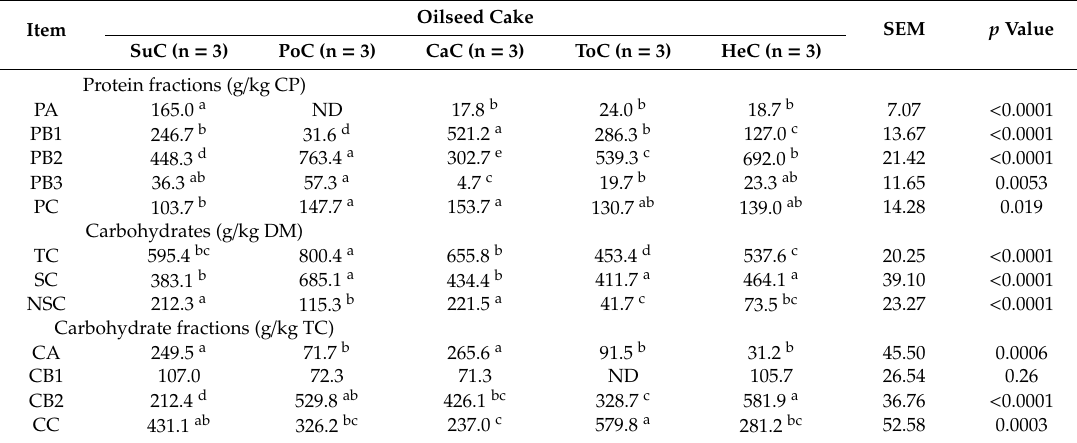
Table 2. Crude protein and carbohydrate fractions of the oilseed cakes according the Cornell Net Carbohydrate and Protein System (CNCPS) system (LSM).